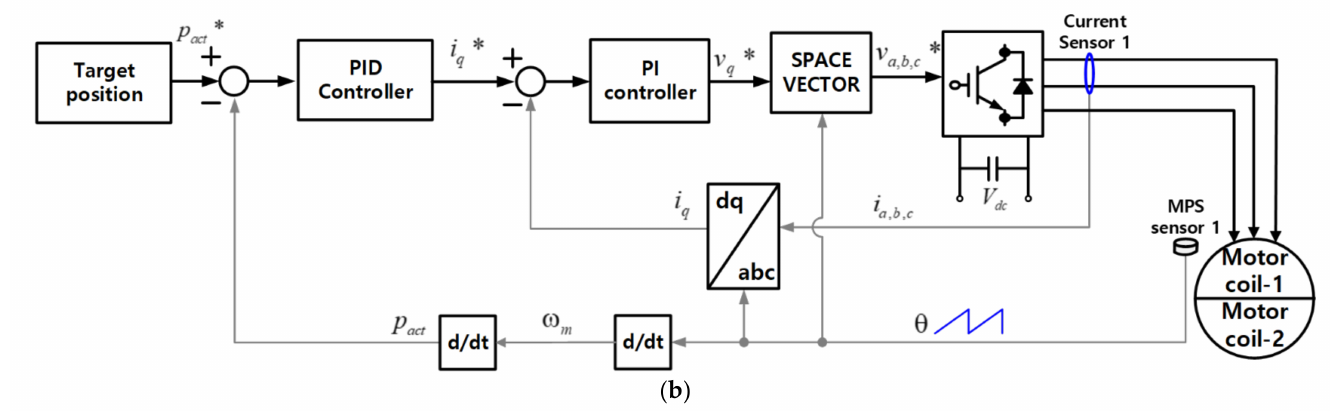
Figure 6. Proposed motor operation control method for aligning the pump piston: ( a ) functional block diagram for speed control of the wall detection process; ( b ) functional block diagram for position control of origin